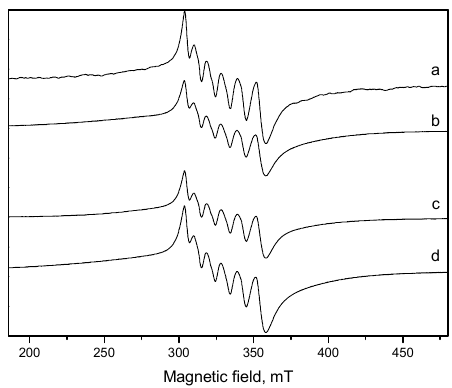
Figure 9. EPR spectra at 123 K of: (a) MnCe(1:0.5)—fresh; (b) MnCe(1:0.5)—after catalytic test.; (c) MnCe(1:2)—fresh; (d) MnCe(1:2)—after catalytic test. There is not any difference between the spectra recorded at different